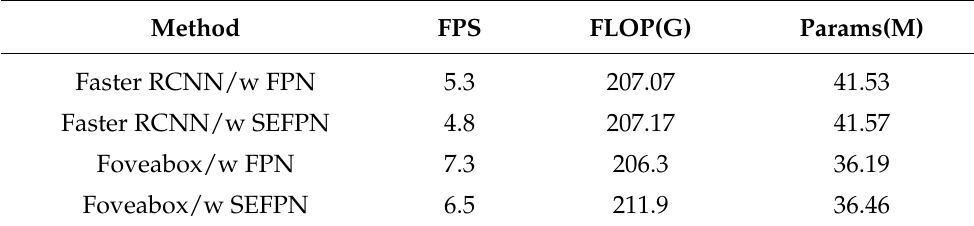
Table 2. Compare the computing cost of Fast RCNN and Foveabox.